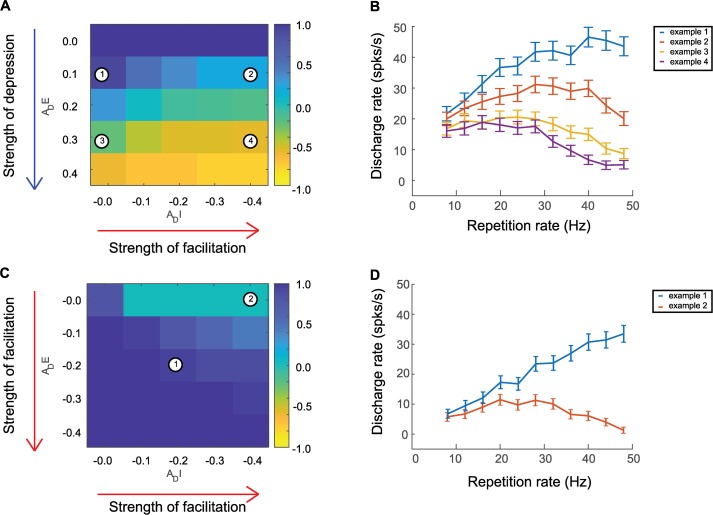
Computational model including short term facilitation.Short term facilitation was added to the model by increasing the probability of release (see methods) at each acoustic input, which would decay back to the initial value with a time constant τp. Initial probability of release was 0.5 compared to 1.0 in short term depression model to compensate for changes in conductance input amplitudes. (A, B.) Depression of excitation and facilitation of inhibition. (C, D.) Facilitation of both excitation and inhibition. (A, C.) average monotonicity index for a given value of adaptation amplitude AD, for time constants {τpE, τpI} ranging between 0.06 and 0.20s. (B, D.) discharge rates for example neurons. (B.) Simulated neurons with depression of excitation and facilitation of inhibition. Example neuron 1 at {ADE = 0.1, ADI = −0.0}, Spearman correlation coefficient = 0.76, P = 0.01. Example neuron 2 at {ADE = 0.1, ADI = −0.4}, Spearman correlation coefficient = 0.25, P = 0.45. Example neuron 3 at {ADE = 0.3, ADI = −0.0}, Spearman correlation coefficient = -0.66, P = 0.03 Example neuron 4 at {ADE = 0.3, ADI = −0.4}, Spearman correlation coefficient = -0.74, P = 0.01 (D.) Simulated neurons with facilitation of both excitation and inhibition. Example neuron 1 at {ADE = -0.2, ADI = −0.2}, Spearman correlation coefficient = -1, P << 0.001. Example neuron 2 at {ADE = -0.0, ADI = −0.4}, Spearman correlation coefficient = 0.07, P = 0.84. Time constants of all example neurons: {τpE = 0.15, τpI = 0.10}.